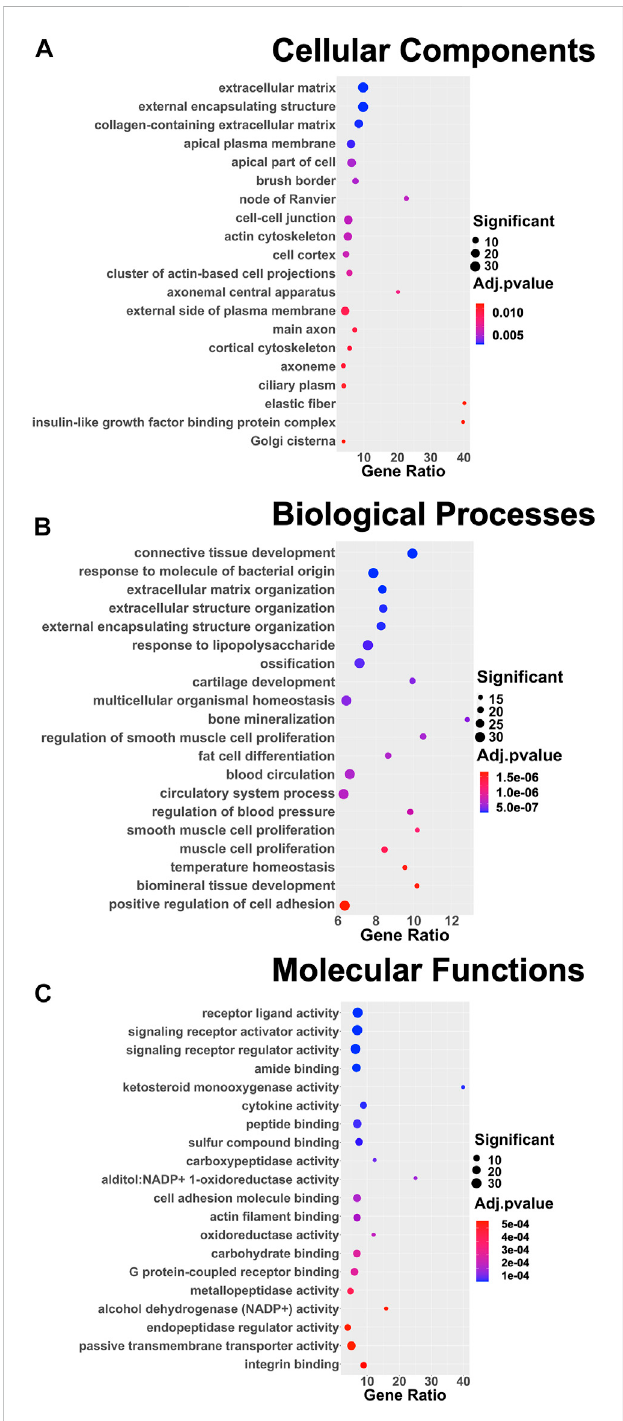
FIGURE 4 Dot plots of the 20 most enriched terms of the three different